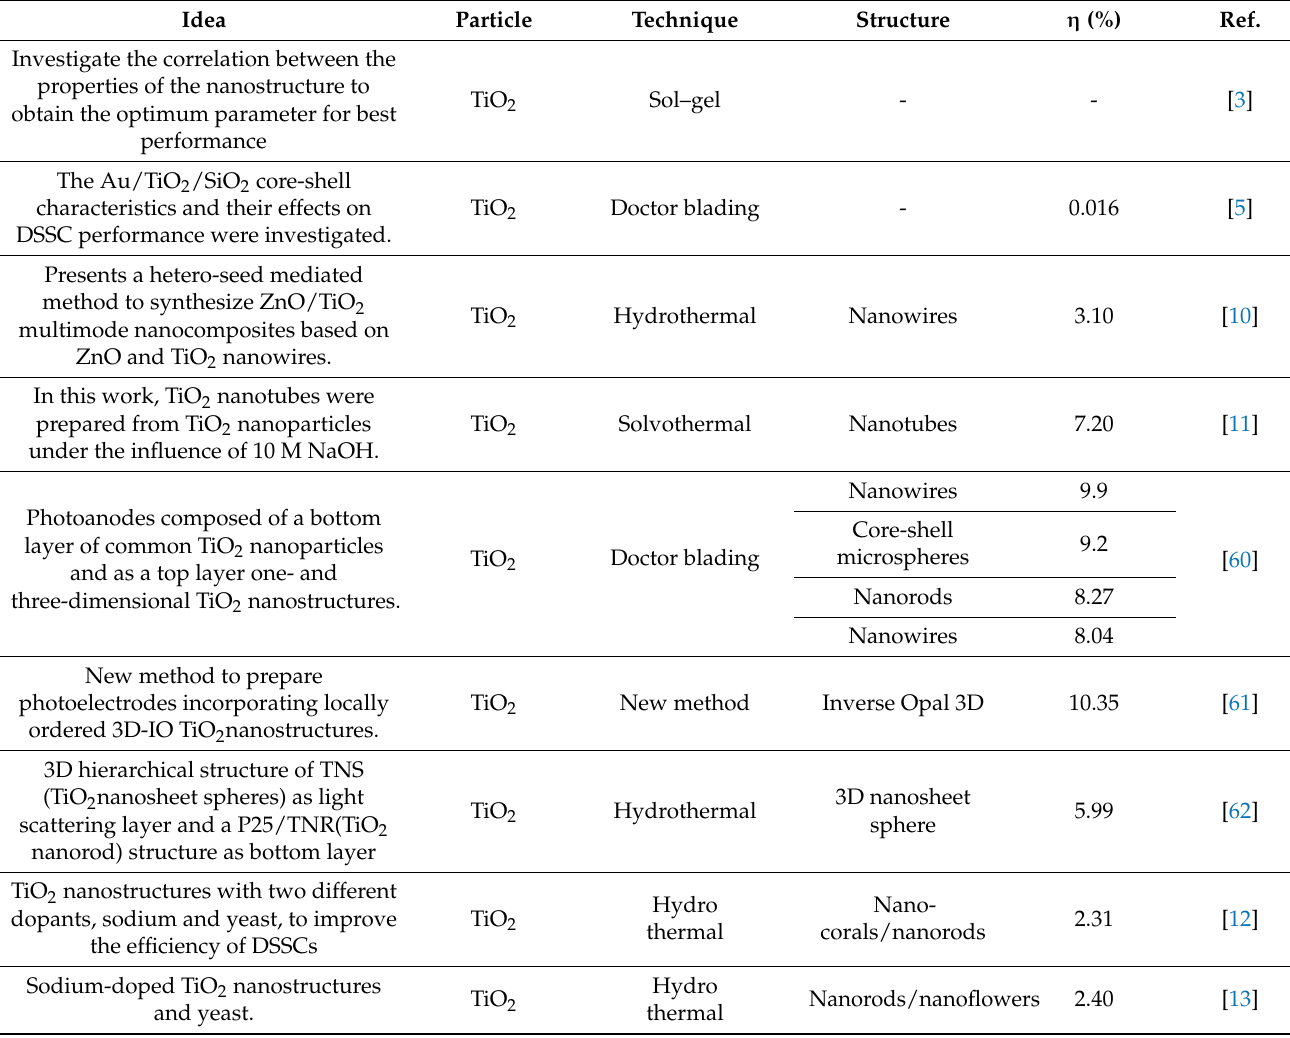
Table 4. Nanostructured TiO 2 and techniques found in recent